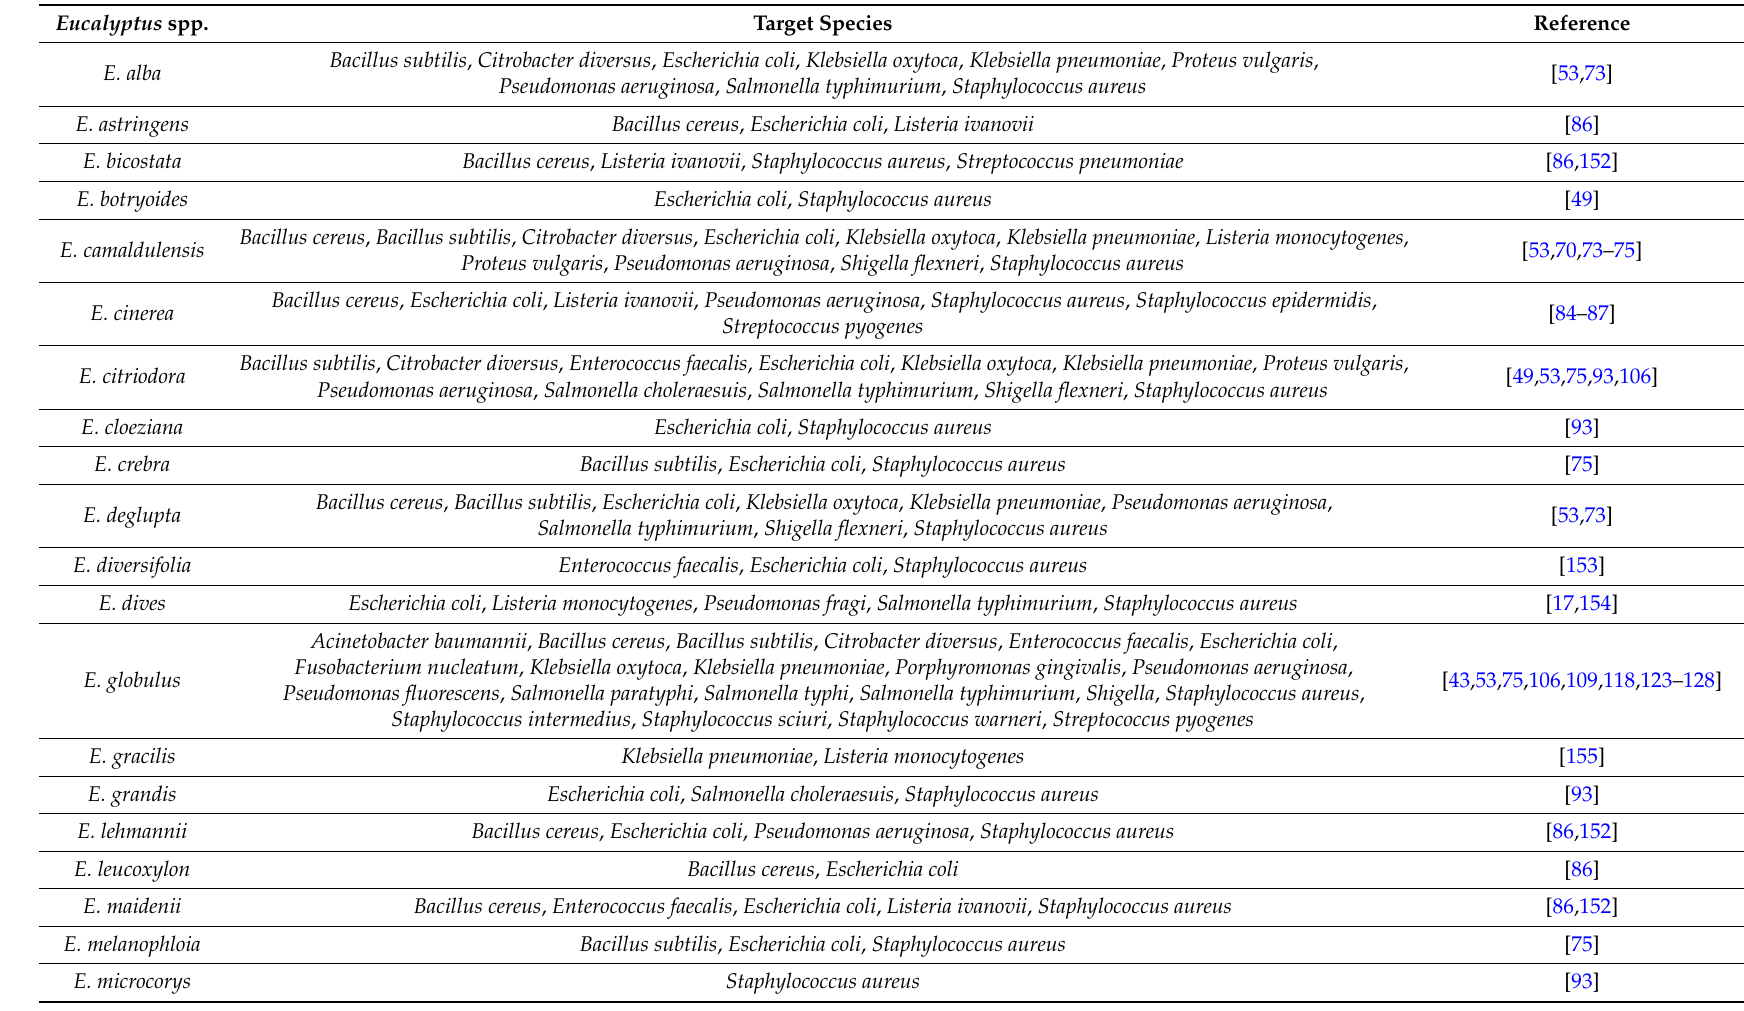
Table 2. Eucalyptus spp. essential oils with antibacterial activities.